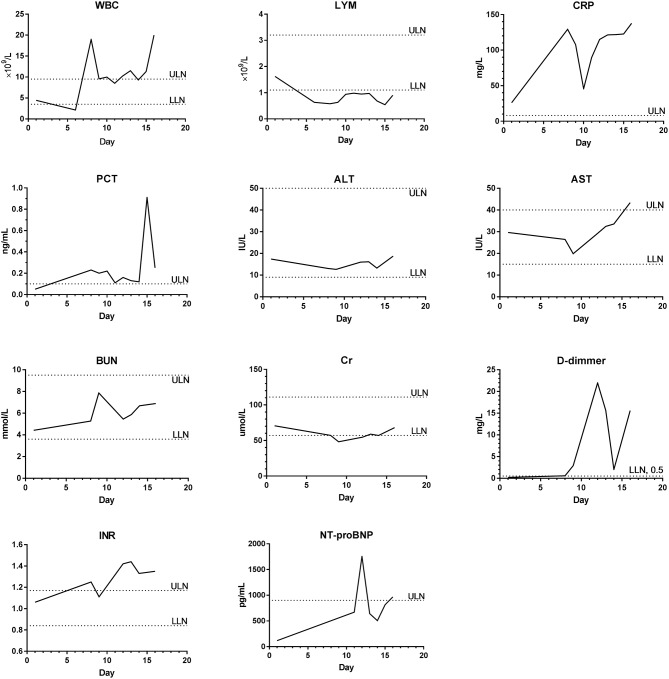
The dynamics of the main laboratory examinations of P6. WBC, White blood cell count; LYM, Lymphocyte count; CRP, C-reactive protein; PCT, Procalcitonin; ALT, Alanine aminotransferase; AST, Aspartate aminotransferase; BUN, Blood urea nitrogen; Cr, Creatinine; INR, International normalized ratio; NT-proBNP, N-terminal pro-B type natriuretic peptide; ULN, Upper limit of normal; LLN, Lower limit of normal.